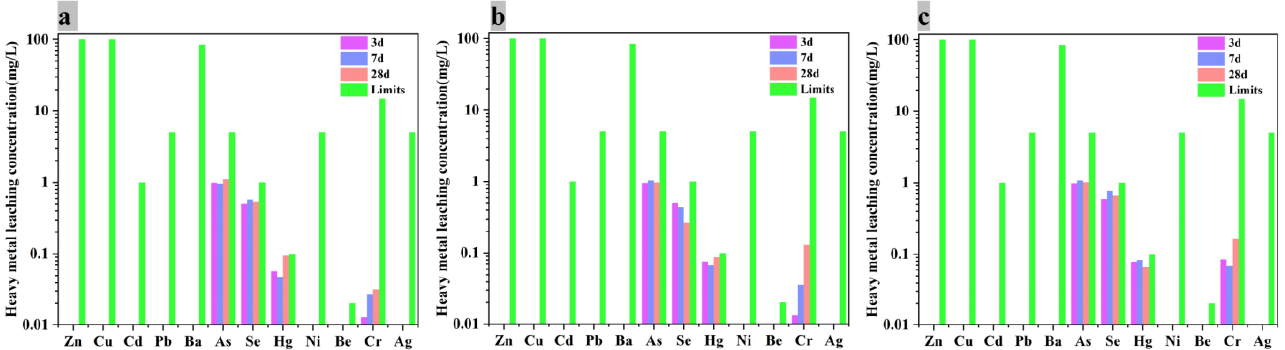
Figure 10. Heavy metal concentrations of leaching solutions. ( a ) PSM3, ( b ) PSM5 and ( c ) PSM7.